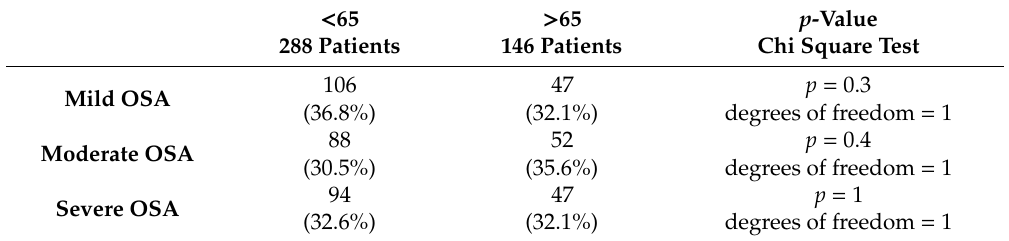
Table 2. Distribution of patients according to Obstructive Sleep Apnea (OSA) severity sub-classes.